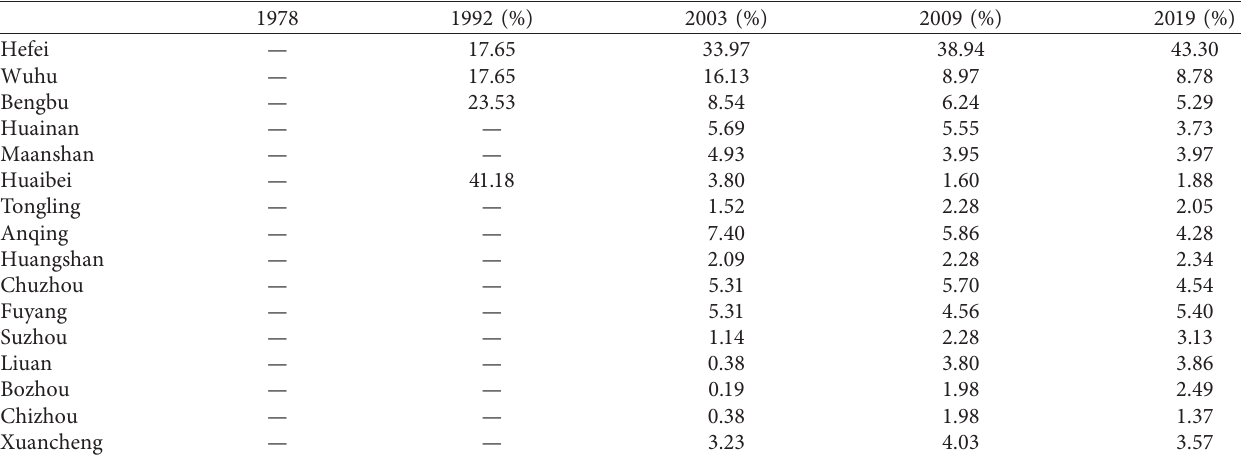
Table 4: Proportion of headquarters-branch enterprise linkages in cities in Anhui